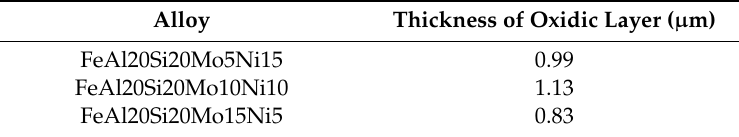
Table 6. Real thickness of an oxidic layer after 100 h at 800 ◦ C observed on an oblique cross-section calculated using Equation